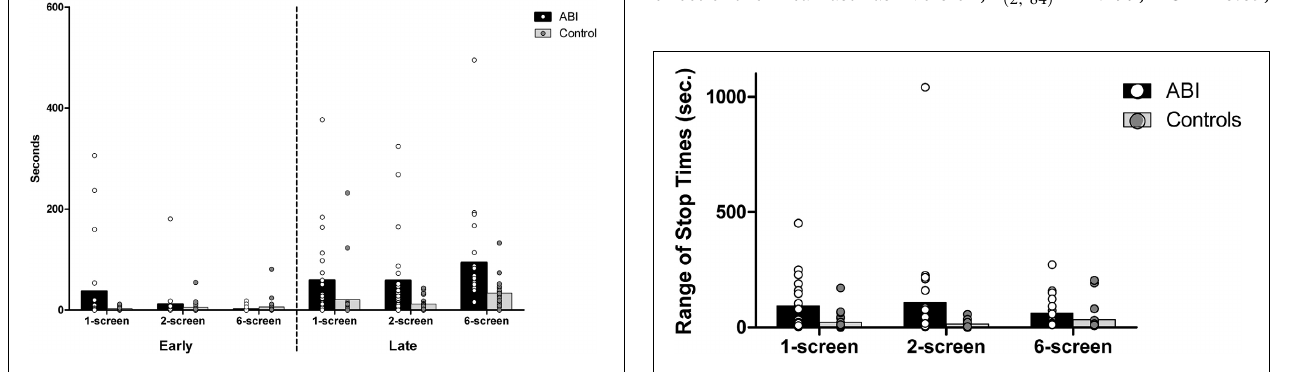
FIGURE 4 | Average early and late stopping discrepancies in seconds. FIGURE 5 | Range of stop times in